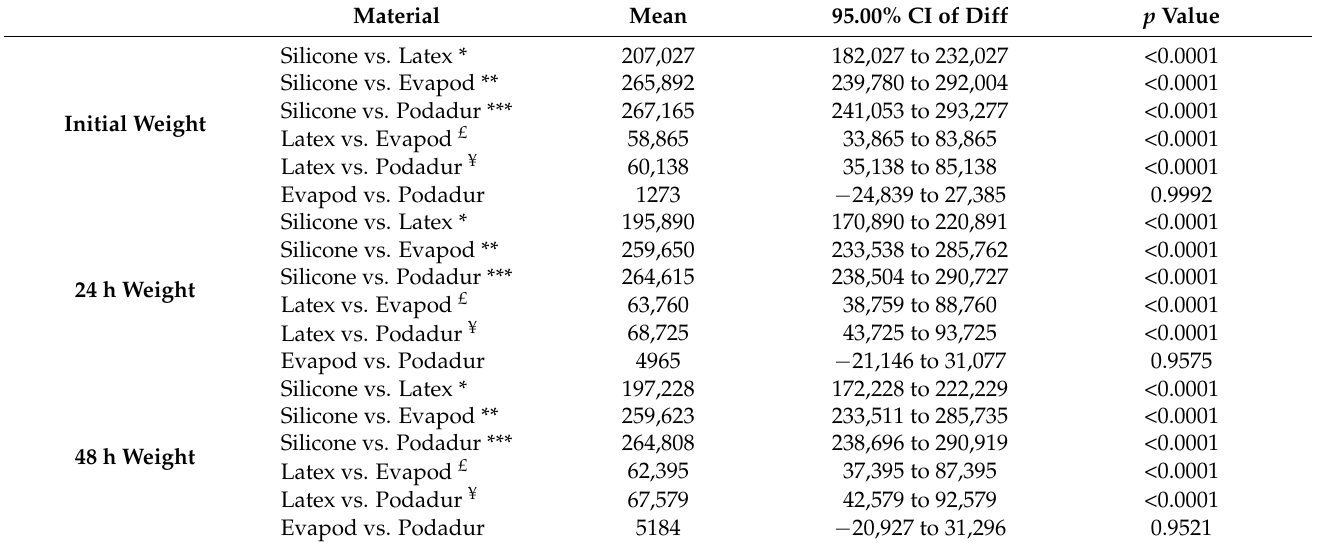
Table 2. Water absorption capacity of materials about weight x